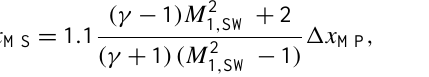
lations’ dependence on solar wind magnetic field are